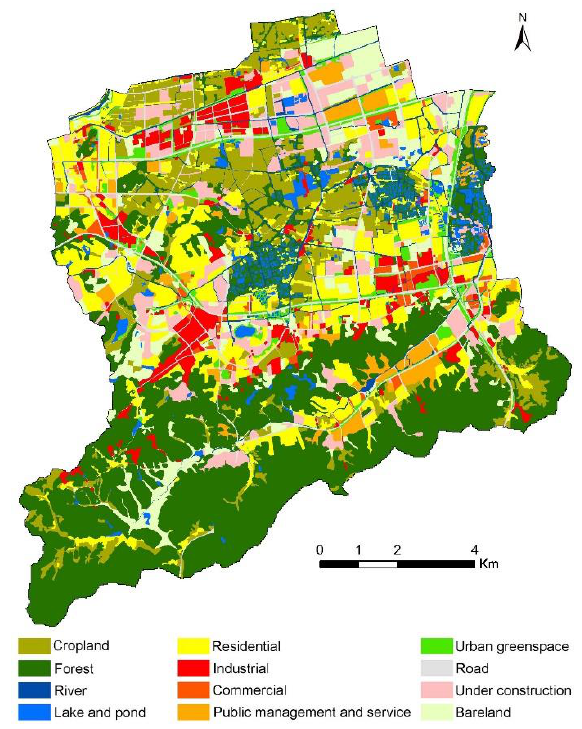
Figure 4. Land use map of the study area.